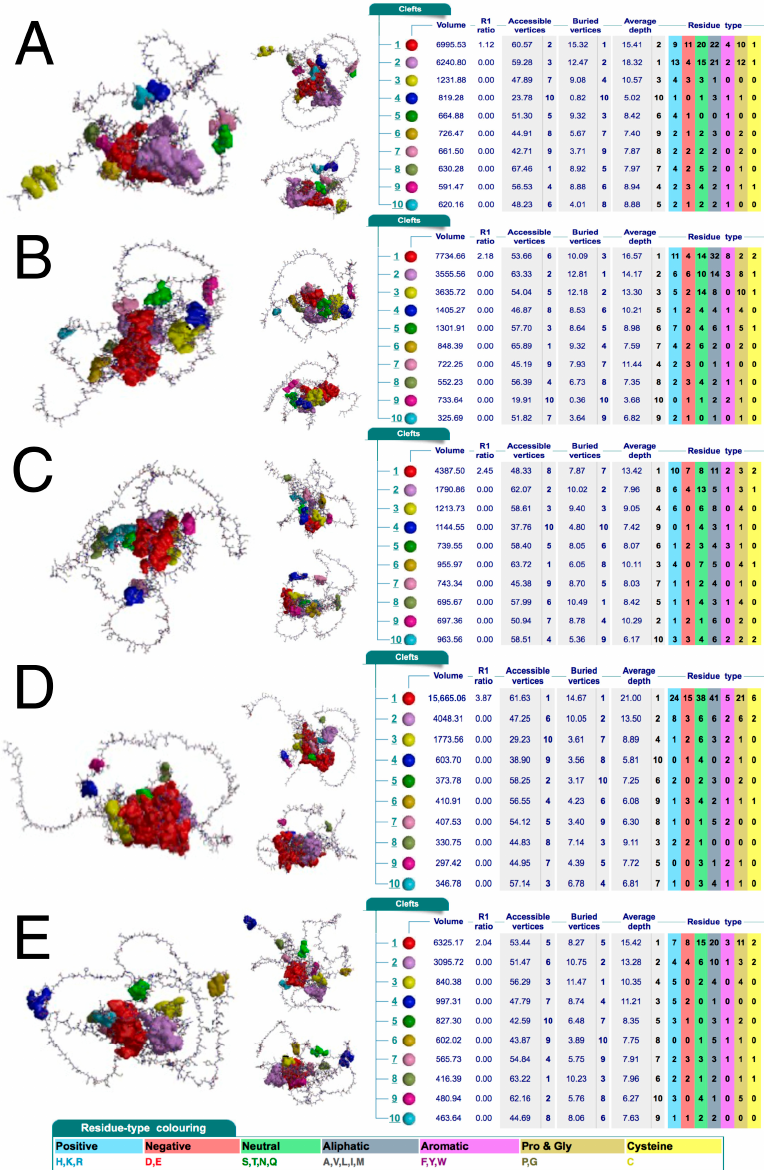
Figure 4. Clefts in the protein structure of AP-2 α ( A ), AP-2 β ( B ), AP-2 γ ( C ), AP-2 δ ( D ), and AP-2 ε ( E ). Three orientations of protein structure with highlighted clefts (marked in various colors that correspond to those in tables) are shown for each AP-2 transcription factor. Accompanied tables with details on the pocket’s volume, R1 ratio, depth, and residue type are visible on the right; the coloring of the latter is below the last subfigure. Data acquired from PDBsum.